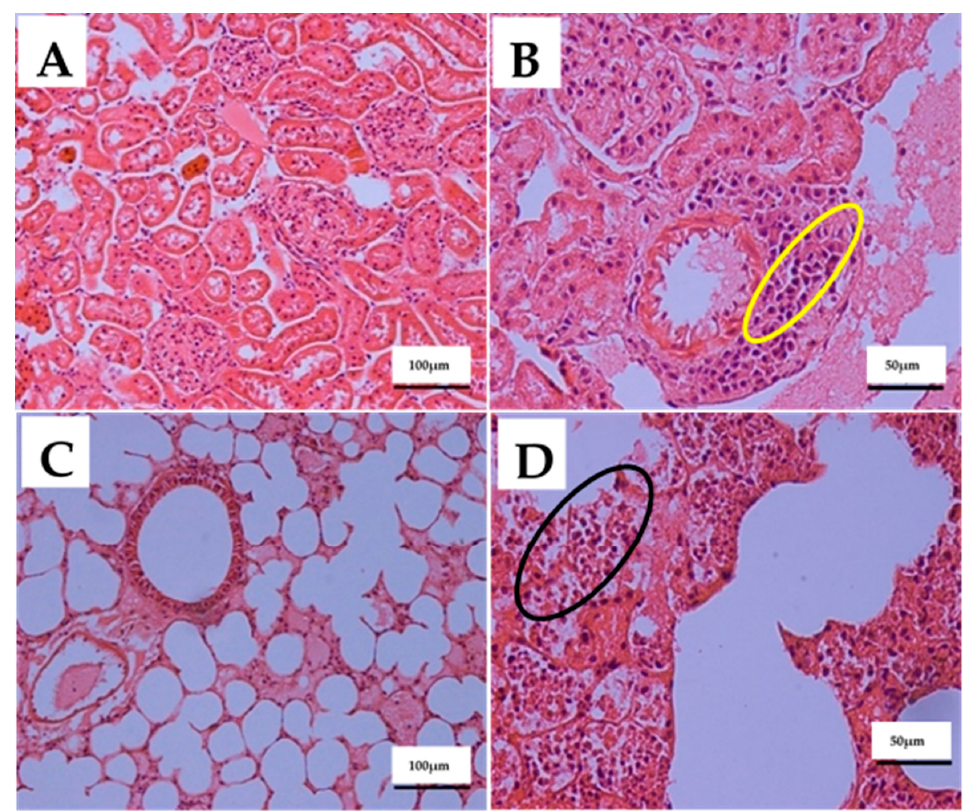
Figure 5. The effects of intraperitoneal (IP) injections of n- ethyl- n- nitrosourea (ENU) on the histology of kidney and lungs of ICR-mice, 12 weeks post injection. Key: ( A ) Photomicrograph of a kidney